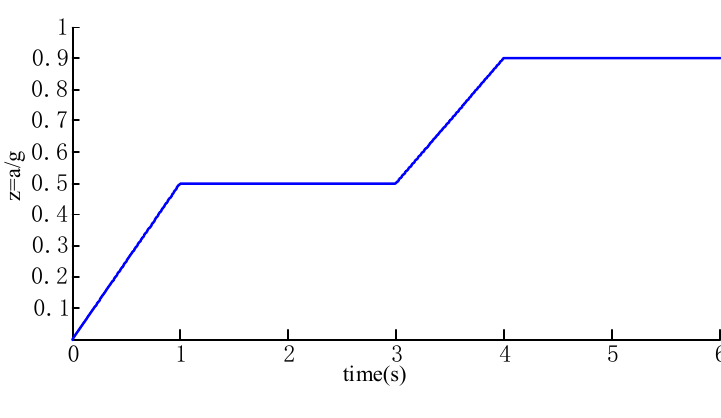
Figure 15. Brake intent variation.